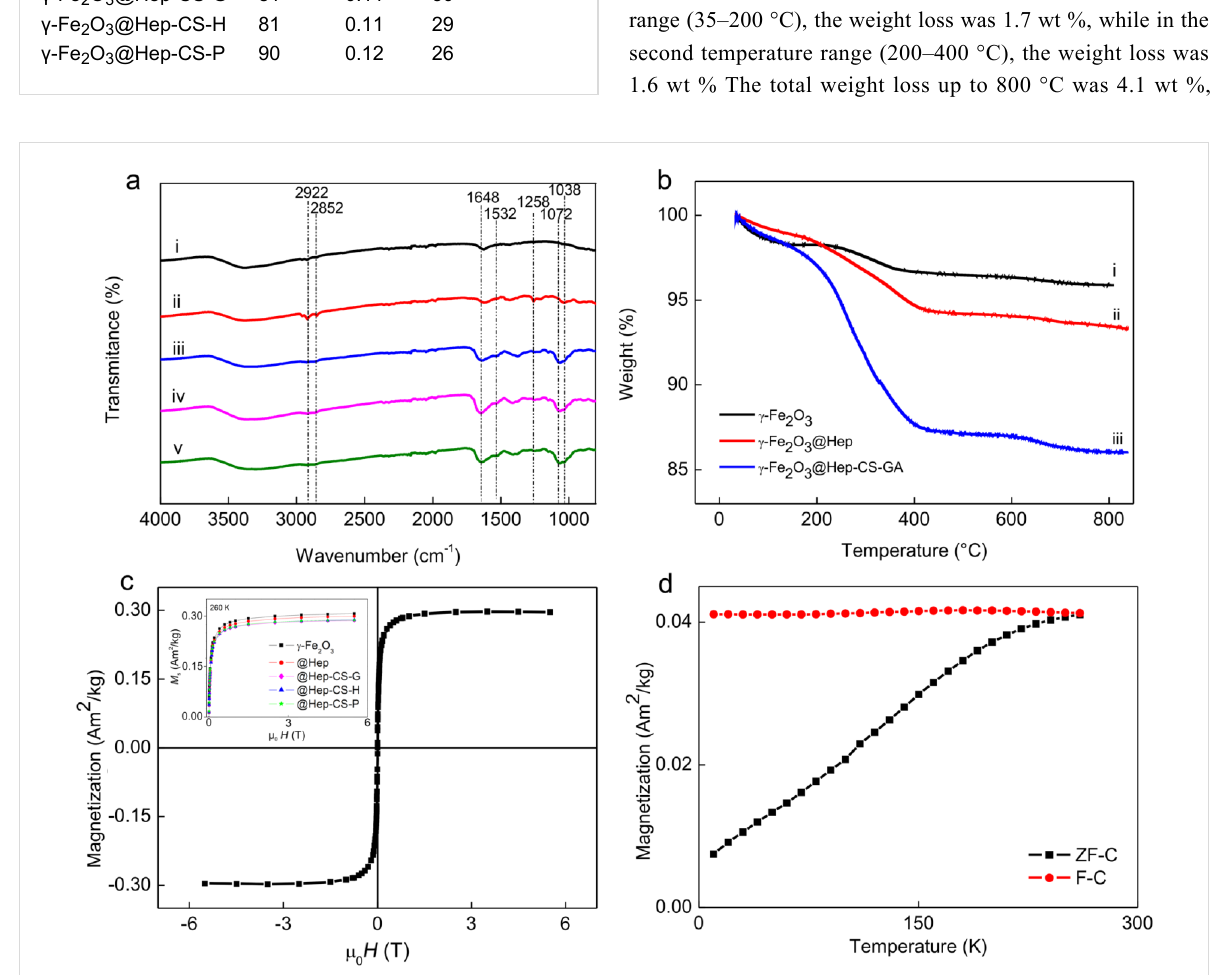
Figure 3: (a) ATR-FTIR spectra of (i) γ -Fe 2 O 3 , (ii) γ -Fe 2 O 3 @Hep, (iii) γ -Fe 2 O 3 @Hep-CS-G, (iv) γ -Fe 2 O 3 @Hep-CS-H, and (v) γ -Fe 2 O 3 @Hep-CS-P nanoparticles. (b) TGA of (i) γ -Fe 2 O 3 , (ii) γ -Fe 2 O 3 @Hep, and (iii) γ -Fe 2 O 3 @Hep-CS-G. (c) Magnetic hysteresis loop of the aqueous γ -Fe 2 O 3 colloid (4.4 mg/mL) at 260 K. The inset shows the magnetization curves of all colloids normalized by the nanoparticle weight. (d) Temperature dependence of the magnetization of the γ -Fe 2 O 3 @Hep-CS-G colloid. H is the applied magnetic field, and μ 0 is the magnetic permeability of vacuum.